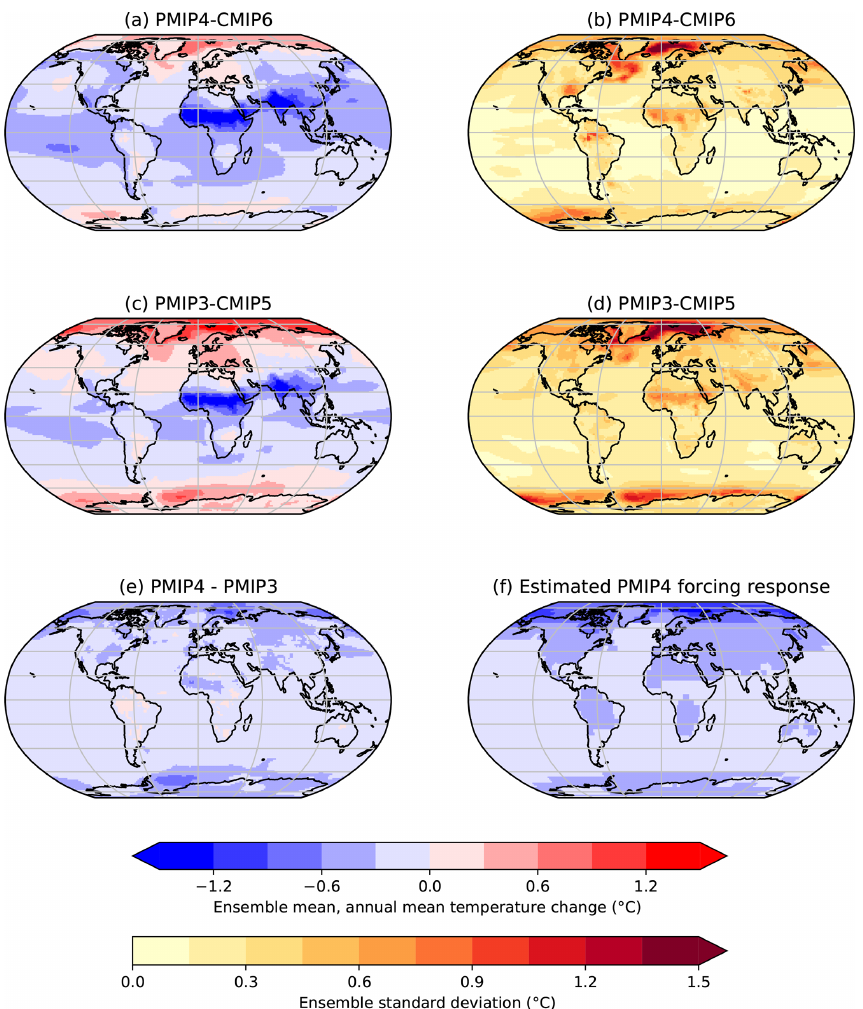
Figure 1. Annual mean surface temperature change in the midHolocene simulations ( ◦ C). (a) The ensemble mean, annual mean temperature changes in PMIP4-CMIP6 (midHolocene – piControl) and (b) the inter-model spread (defined as the across-ensemble standard deviation). (c) The ensemble mean, annual mean temperature change in PMIP3-CMIP5 and (d) its standard deviation. (e) The difference in temperature between the two ensembles. (f) The estimated response to the greenhouse gas concentration reductions in the experimental